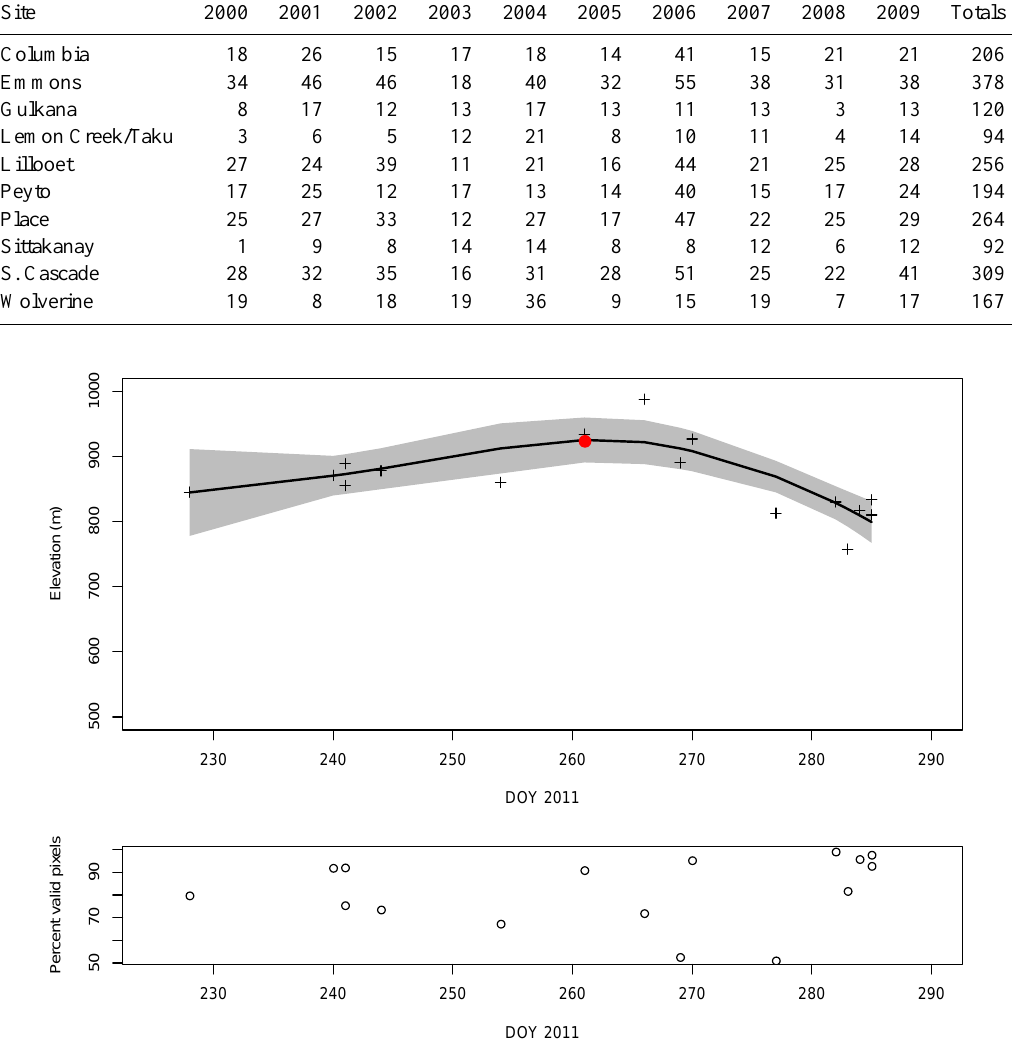
Fig. 4. Top panel: observations (crosses) of Z S( 20 ) by day of year (DOY) for the Wolverine Glacier region, 2011 ablation season. The lowess curve (black) with standard errors (grey) is weighted by the percentage of cloud-free pixels (bottom panel) in each scene. The maximum value on the lowess curve (red) is assumed to represent the annual